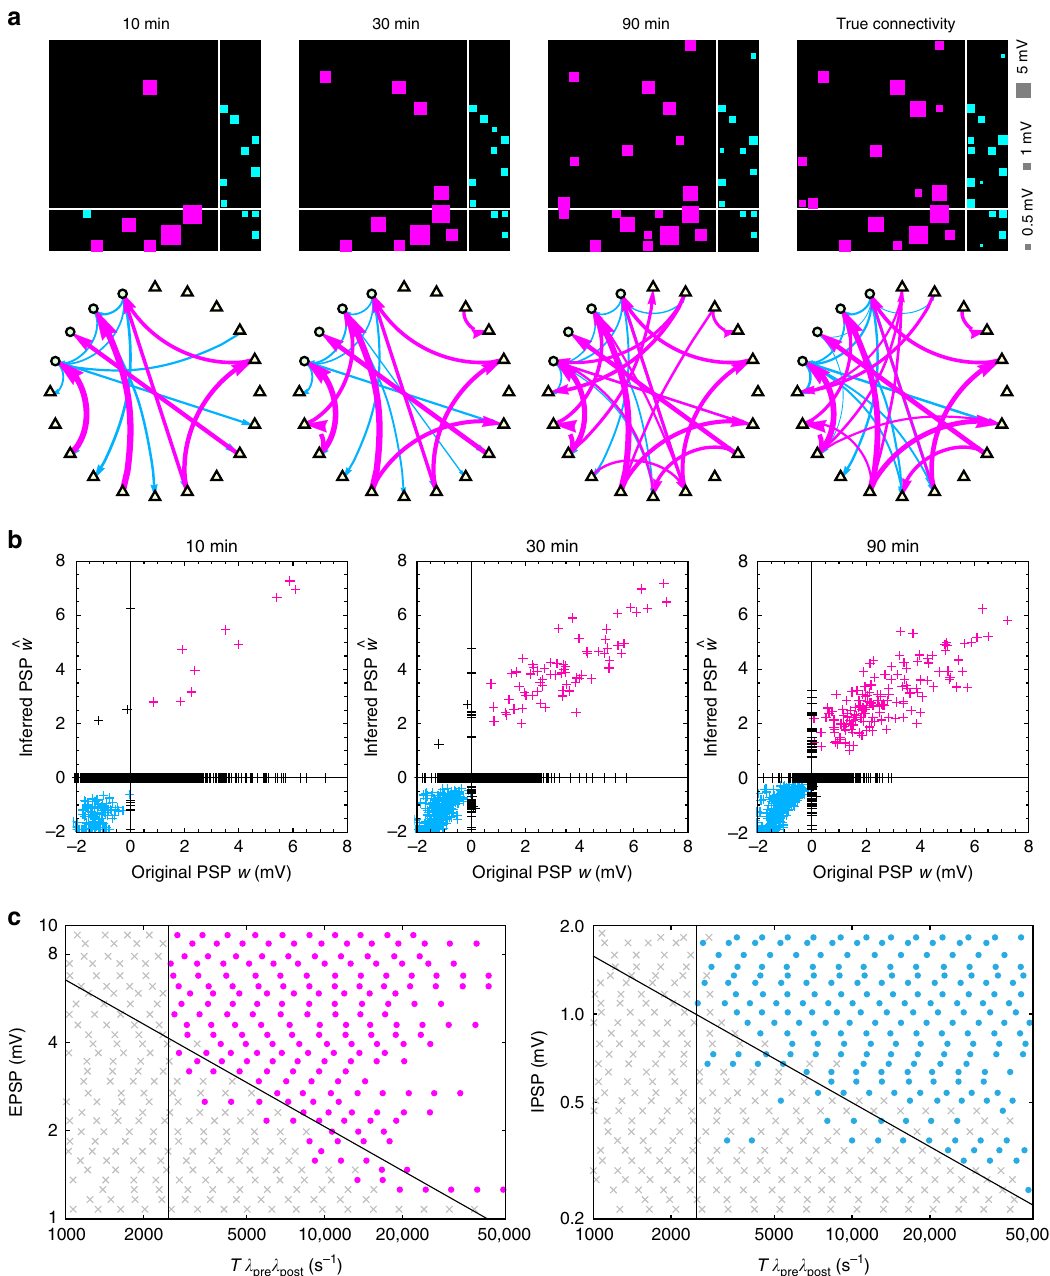
Fig. 3 Neuronal circuits reconstructed from different observation time windows. a Neuronal connections estimated from the observation time windows of 600, 1800, and 5400 s (10, 30, and 90 min) are plotted in reference to true connectivity. In each connection matrix, the x -axis indicates reference neurons. In the network graphs shown in the second panel, excitatory and inhibitory neurons are depicted as triangles and circles, respectively. b Estimated postsynaptic potentials (PSPs) ( ^ w ) plotted against true parameters ( w ) were computed for 100 neurons randomly selected from the simulation. Points in the fi rst and third quadrants represent qualitatively correct inferences for excitatory and inhibitory connections (magenta and cyan, respectively). Points on the nonzero y -axis represent the false positive connections for unconnected pairs. Points on the nonzero x -axis represent the false negatives. c Detection status for connections of given PSPs with respect to the observation window ( T ). Connections estimated as excitatory and inhibitory are colored magenta and cyan, respectively, while undetermined ones are colored gray. Diagonal and vertical lines represent the theoretical formulas (3) and (4), respectively. Source data are provided as a Source Data fi